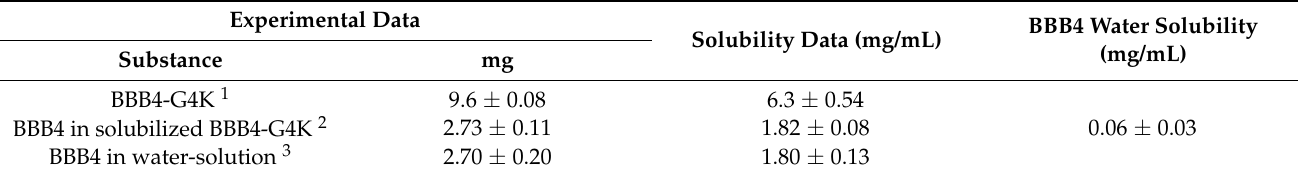
Table 4. Results obtained from solubility experiments performed on BBB4-G4K NPs. Experimental Data